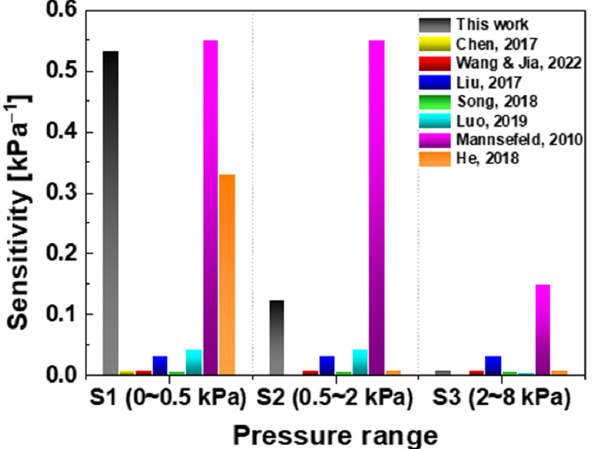
Figure 5. Comparison of sensitivity between previously reported MEMS pressure sensors and this